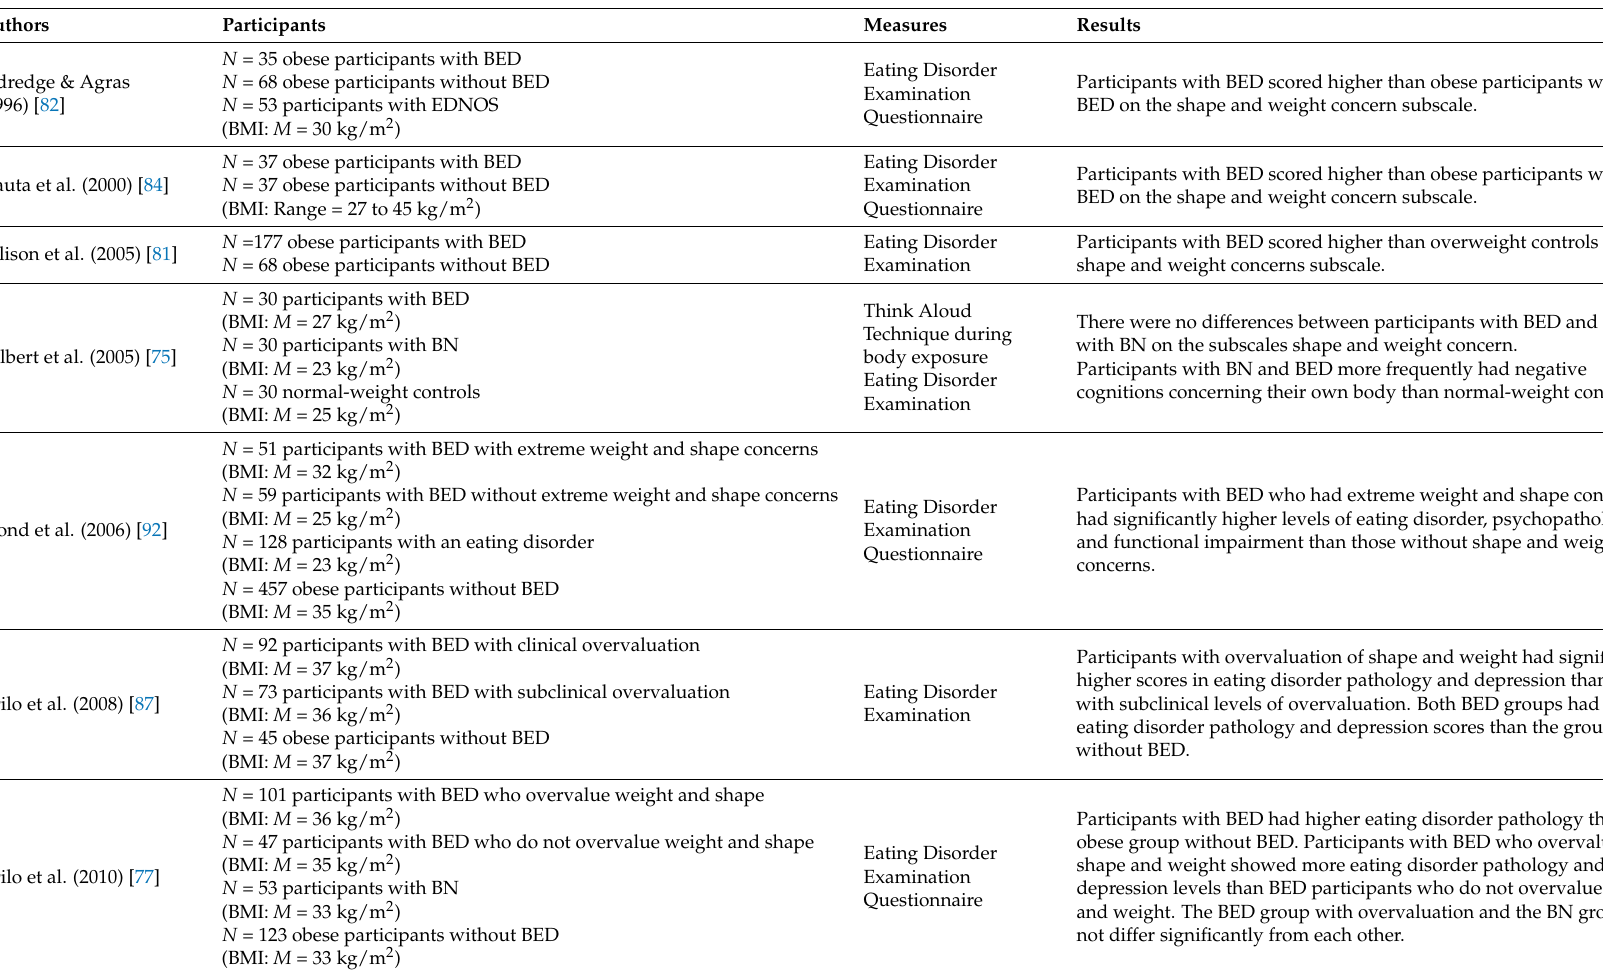
Table 2. Studies of overconcern with weight and